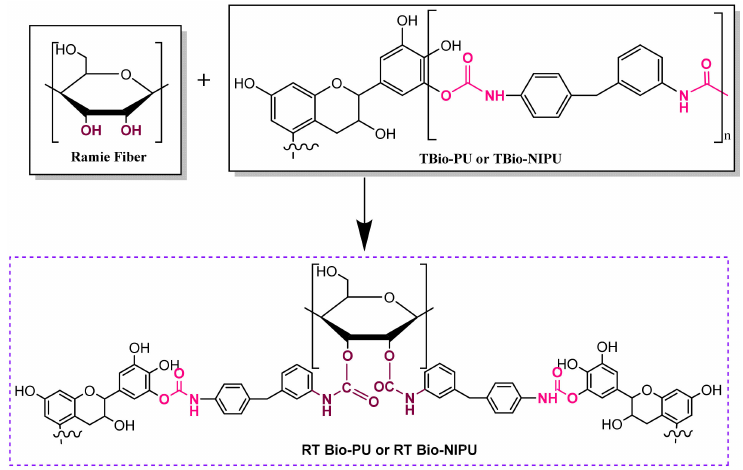
Figure 10. Possible mechanism reaction of ramie with resins.